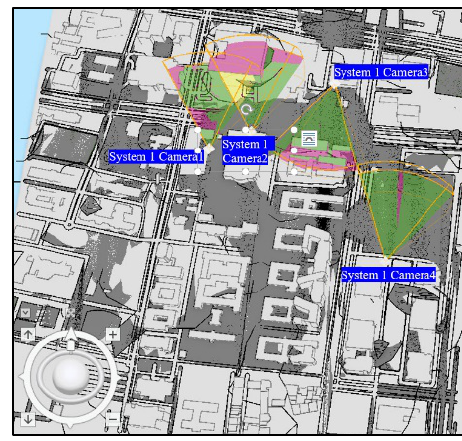
Figure 8. multiple CCTV systems coverage at